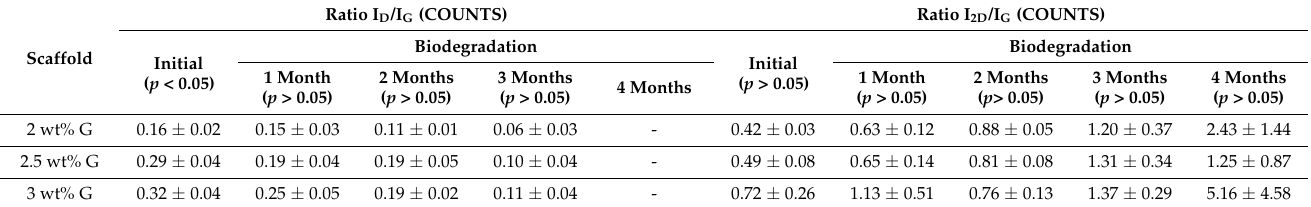
Table 1. Ratio I D /I G band and I 2D /I G of PCL/G scaffold biodegradation over four